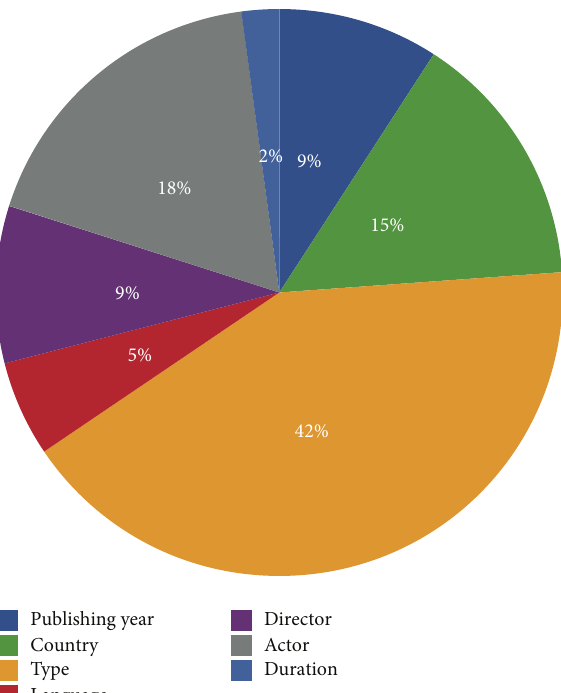
Figure 4: Survey of top three liked movie factors.